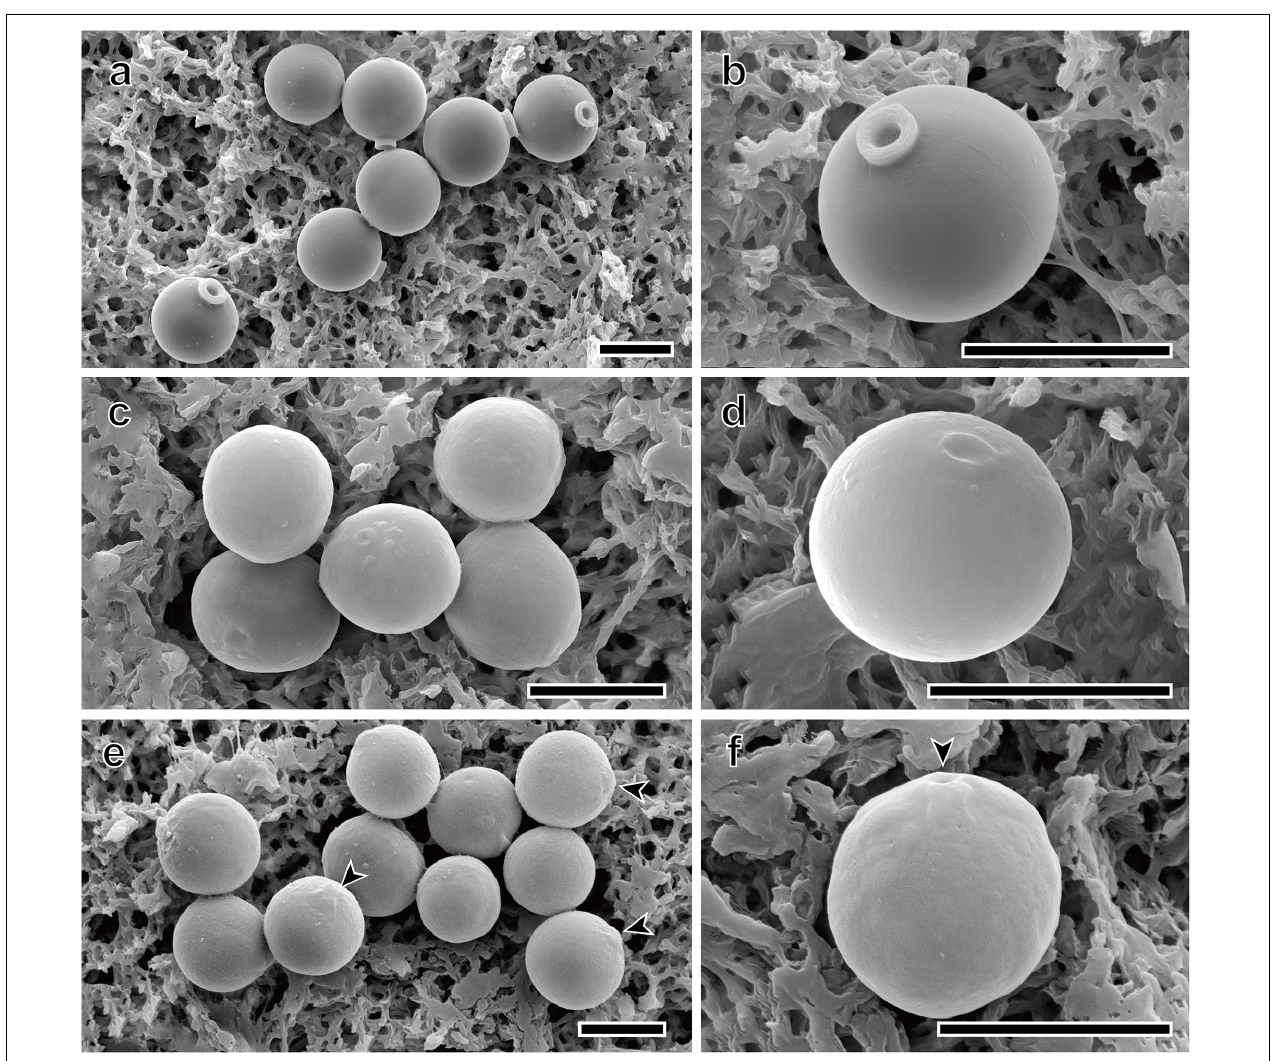
FIGURE 5 | Scanning electron micrographs of three new Spumella species. (a,b) SEM images of the spherical stomatocyst of S. longicolla Yangrim041319B6. (c,d) SEM images of the oblate stomatocyst of S. oblata Sanggul120118B3. (e,f) SEM images of the spherical stomatocyst of S. rotundata Woeam020118A5. Arrowheads indicate a pore of the stomatocyst. Scale bars = 5 µ